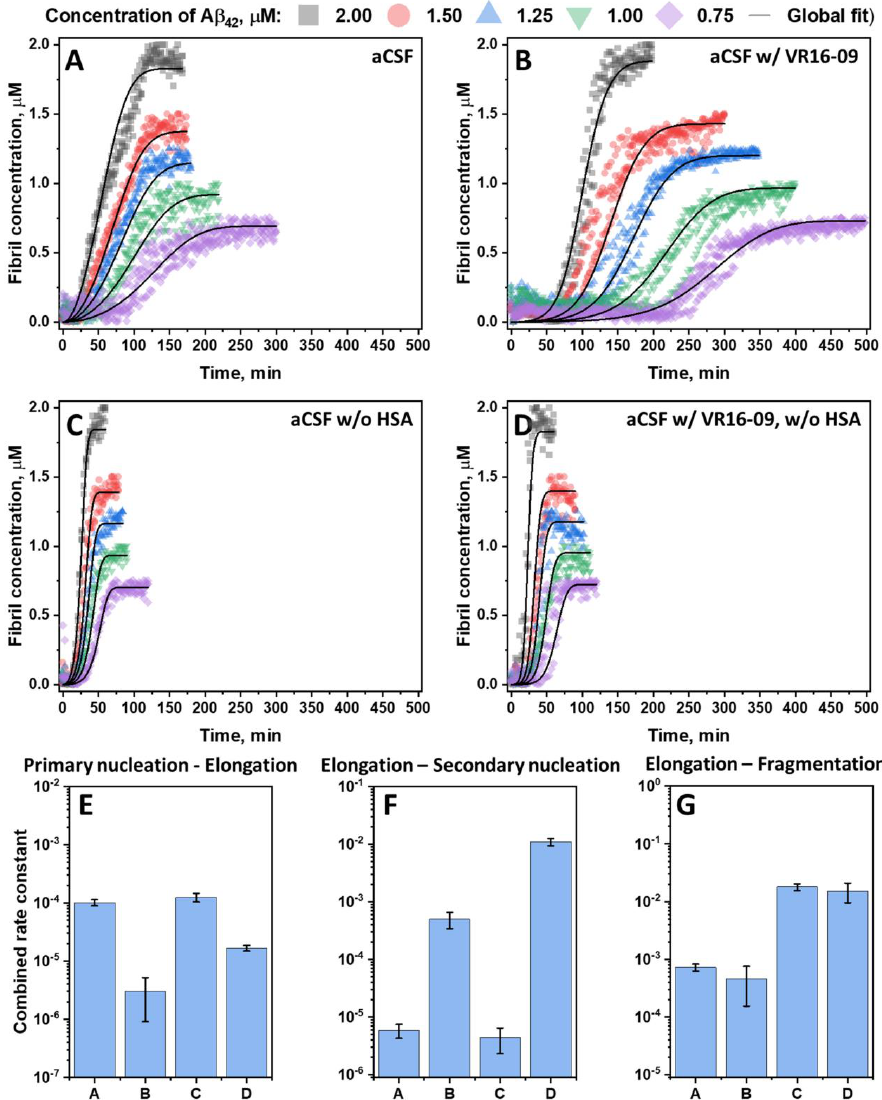
Figure 4. A β 42 aggregation kinetics in aCSF ( A ), aCSF with 25 µ M VR16-09 ( B ), aCSF without HSA ( C ), and aCSF with 25 µ M VR16-09 and without HSA ( D ). The fibril concentration in the Y axis is the concentration of monomers in their aggregated state (assuming the aggregation efficiency was 100%). For each condition, a four-step global-fitting aggregation model was used. Combined pri- mary nucleation–elongation ( E ), elongation–secondary nucleation ( F ), and elongation–fragmentation ( G ) rate constants were obtained at each condition by global-fit of the Aβ 42 concentration range (0.75–2 μM). Error bars are one standard deviation (n = 3).